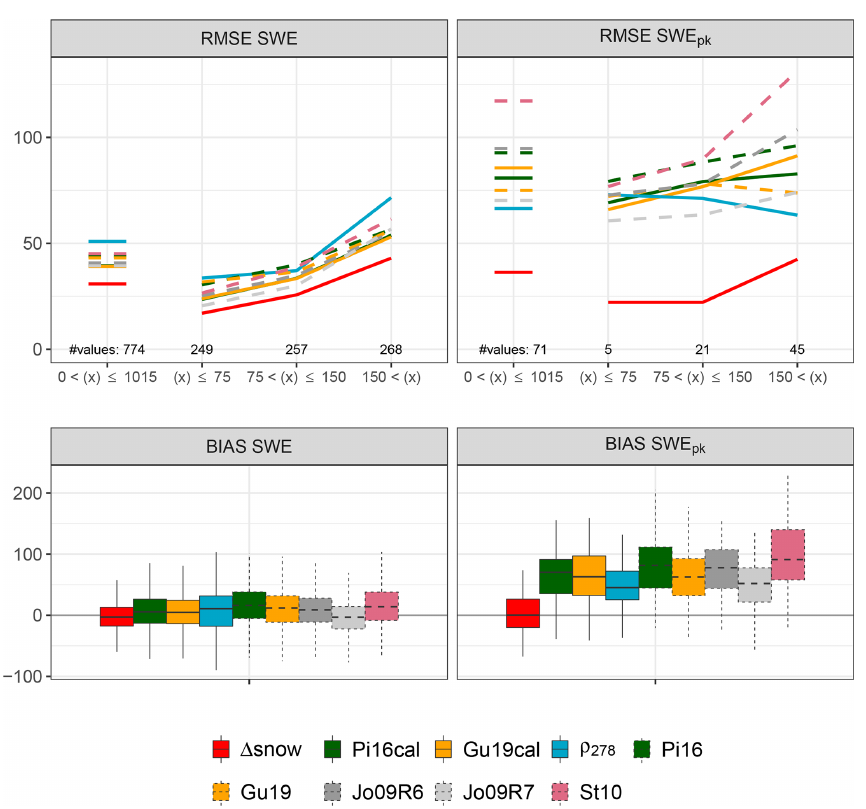
Figure 2. Root mean square errors (RMSE) and biases (BIAS) between the (cid:49) SNOW model and different empirical regression models from the SWE val observations. The (cid:49) SNOW model, models by Pistocchi (2016) and Guyennon et al. (2019), and the “constant density approach” were calibrated with SWE cal data ( (cid:49) SNOW , Pi16cal, Gu19cal, ρ 278 ; upper panels, solid lines). Dashed lines indicate the Pistocchi (2016), the Guyennon et al. (2019), the Jonas et al. (2009), and the Sturm et al. (2010) models with their standard parameters (Pi16, Gu19, Jo09R6, Jo09R7, and St10). Jo09R6 and Jo09R7 together illustrate the maximum possible spread of the Jonas et al. (2009) model since Region 6 (R6) and Region 7 (R7) are characterized by the highest and lowest “region-specific offset”, respectively. The upper left panel shows RMSEs for all SWE val values (short horizontal lines) as well as for three SWE classes: SWE ≤ 75, SWE > 150, and intermediate. Analogously for SWE pk (upper right panel), RMSEs are shown. The boxes for the biases (lower panels) encompass 774 values (left panel, SWE) and 71 values (right panel, SWE pk ) and spread from the 25% to the 75% quantiles; the whiskers indicate 1.5 times the interquartile range. Units are kgm − 2